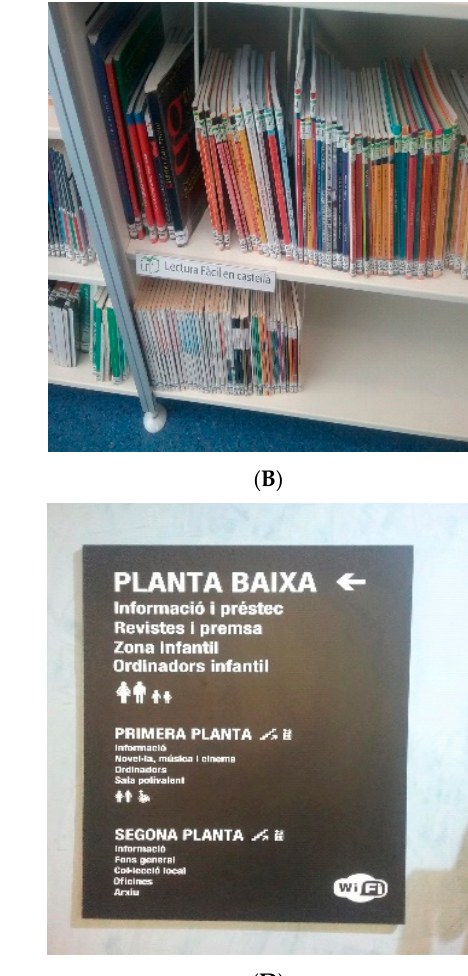
Figure 3 Identified and tested adaptation examples.